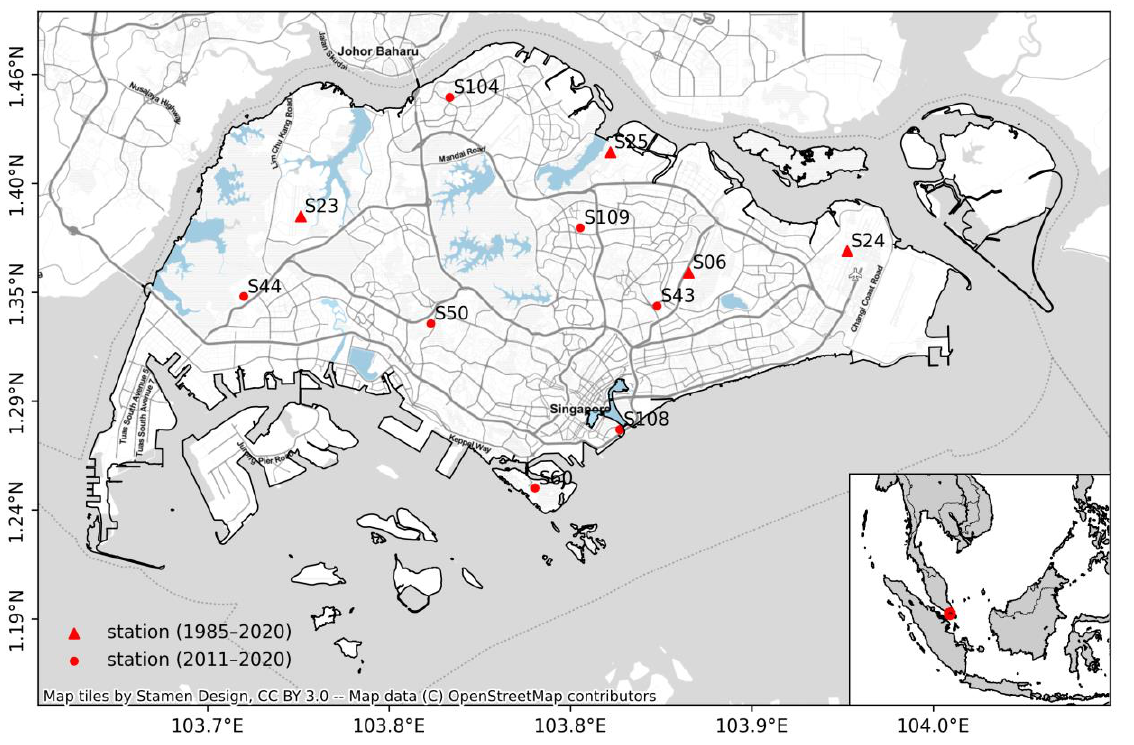
Figure 1. Study area and the location of the 11 selected meteorological stations in